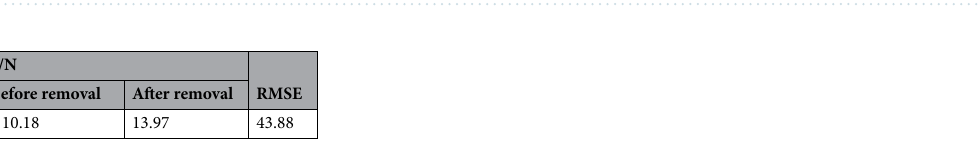
Figure 5. Time and frequency information for a signal polluted by single-frequency interference before and after filtering.